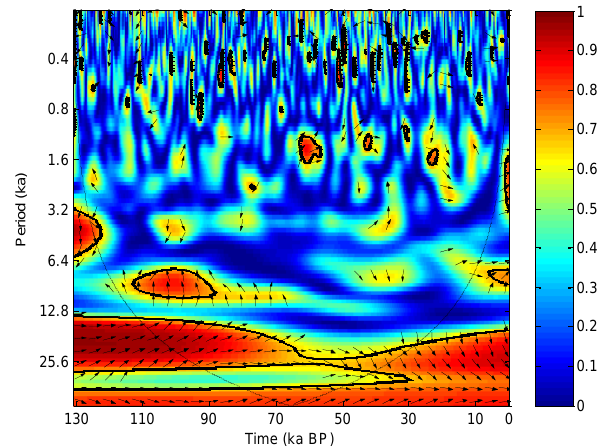
Fig. 5 . Squared wavelet coherence between the simulated August–September Fig. 5. Squared wavelet coherence between the simulated August– September Guliya SAT and the Guliya δ 18 O-temperature proxy Guliya SAT and the Guliya δ 18 O - temperature proxy record. The 5% significance record. The 5% significance level against red noise is shown as a level against red noise is shown as a thick line. The arrow points rightward for an thick line. The arrow points rightward for an in-phase relationship and points leftwards for an anti-phase in-phase relationship and points leftwards for an anti-phase relationship.